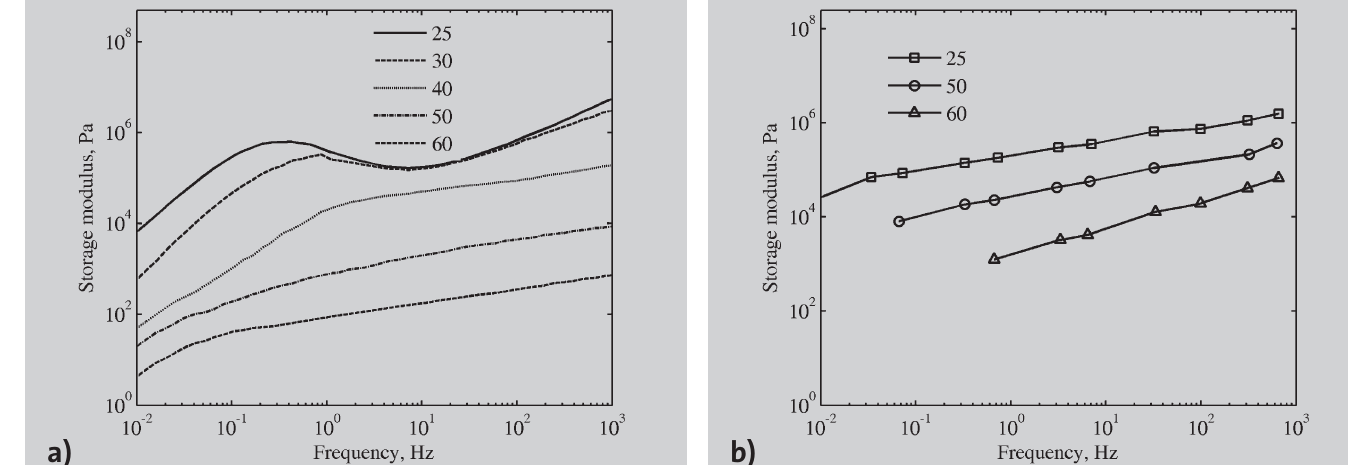
Figure 6: Comparison of the frequen- cy dependence of the mod- uli at different tempera- tures (parameters as given in Table 1, Asphalt 1): (a) Model results, (b) Experimental data trends.